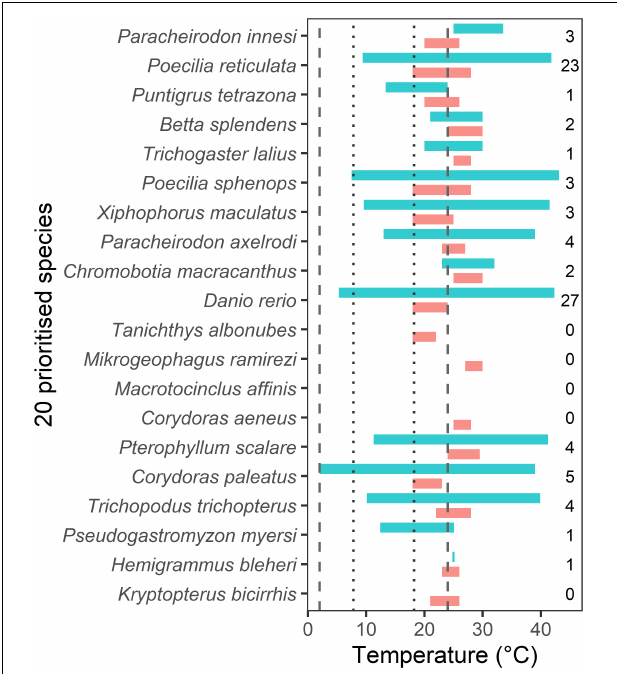
FIGURE 4 | Temperature tolerance ranges for the 20 prioritized aquatic ornamental species imported to New Zealand. Data are from FishBase (red bars) and structured literature searches (blue bars). The numbers of relevant studies from which the data was derived are shown on the right. The ranges shown for literature-based data include the maximum and minimum temperatures from all studies assessed for each species, regardless of methods and locations (or fish populations). The dotted and dashed lines show the temperature range of New Zealand’s riverine waters (Scarsbrook, 2006) and lake waters (Hamilton et al., 2012; Jones and Hamilton, 2014),